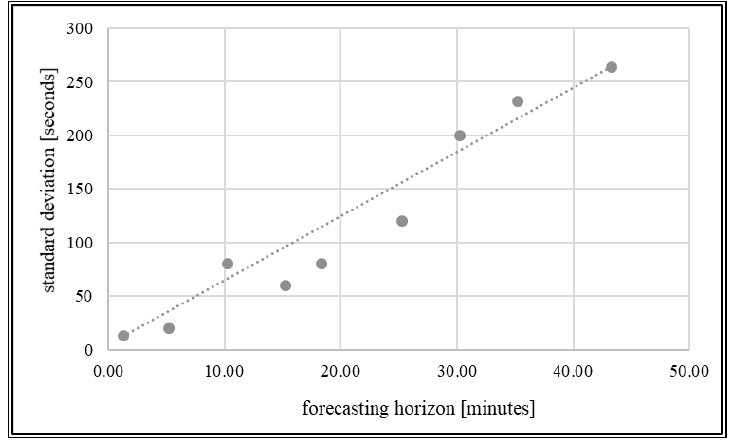
Figure 5. Empirical relation between standard deviation and forecasting horizon.